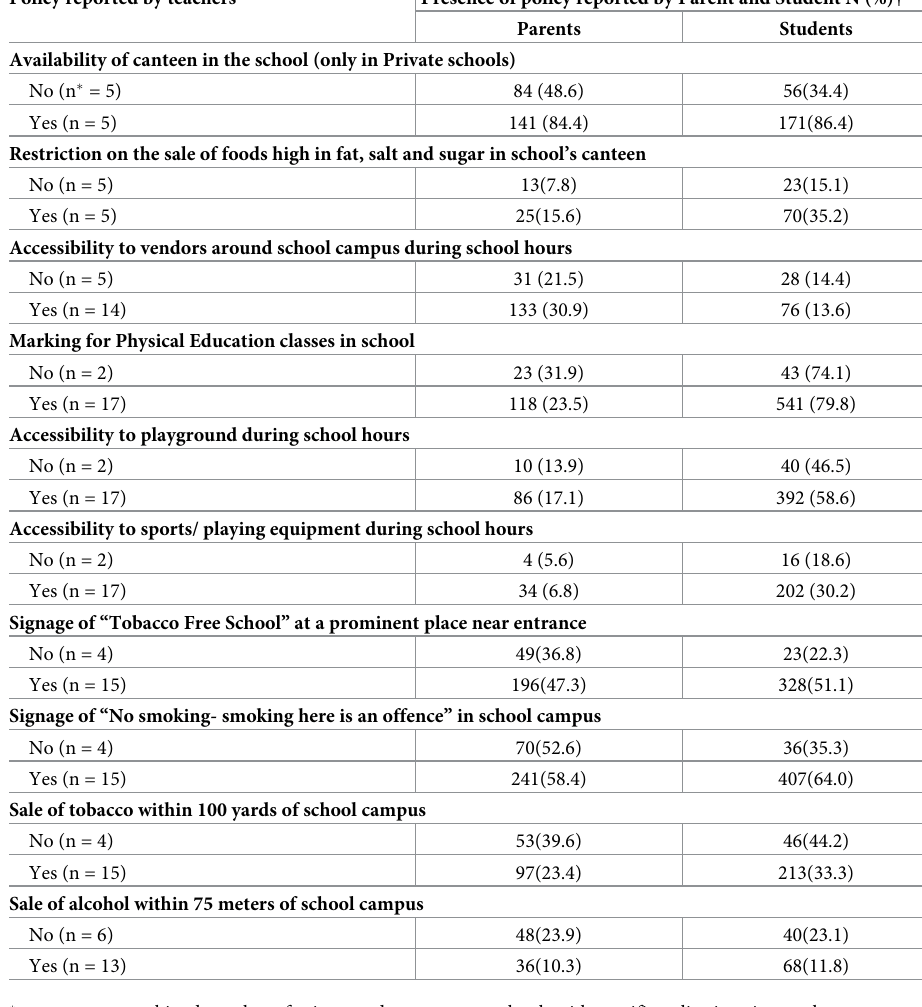
Table 4. Practices and environment in relation to major NCD risk factors as reported by students of Grade 11, parents of Grade 2 students by existence of policy in school (as reported by teachers). Policy reported by teachers Presence of policy reported by Parent and Student N (%)† Parents Students Availability of canteen in the school (only in Private